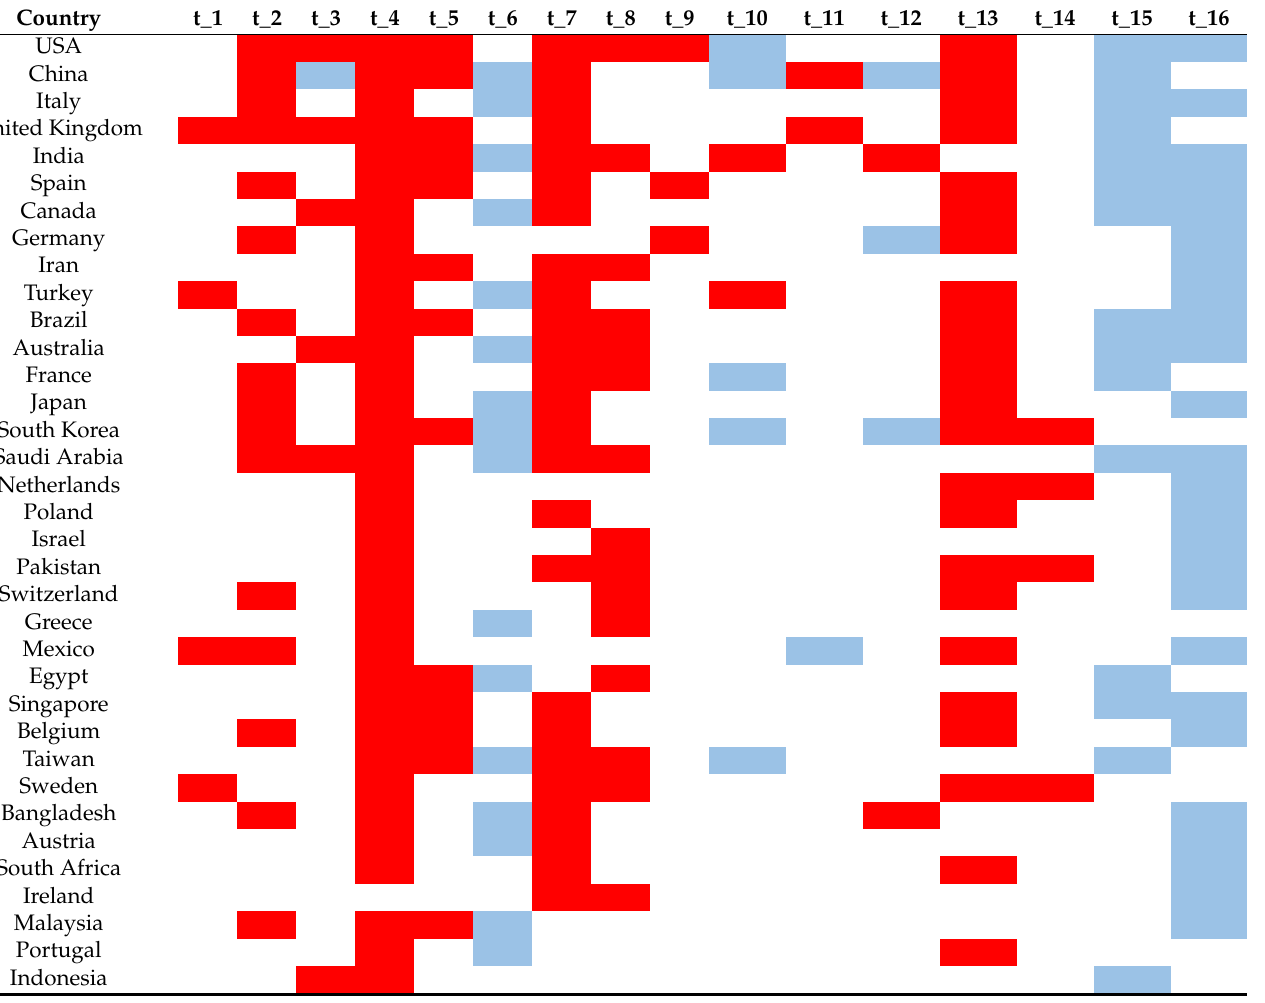
Table 5. Topic trends research in COVID-19 during February 2020–January 2022. Red color indicates increasing tendency, blue decreasing tendency, and white fluctuating or no prominent